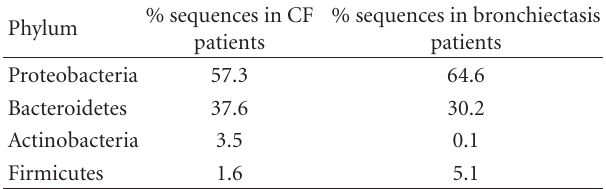
Table 2: Phyla detected in lungs.